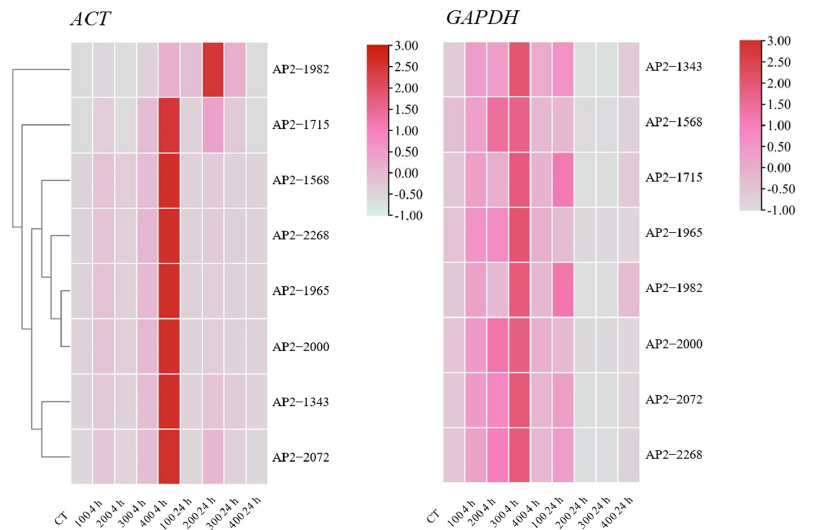
Figure 6. Expression heatmaps of eight transcription factors in S. ferganica under NaCl stress. The best ( ACT ) and worst ( GAPDH ) reference genes were used to normalize the expression data. cDNA and the above gene expression analysis were the same samples in this experiment. Samples were collected from five-day-old seedlings subjected to 0, 100, 200, 300, and 400 mmol/L NaCl stress after 0, 4, and 24 h of treatment.